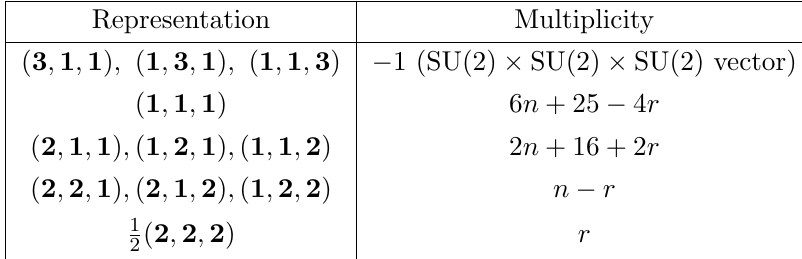
Table 9 . The spectrum for G = SU(2) (cid:2) SU(2) (cid:2)